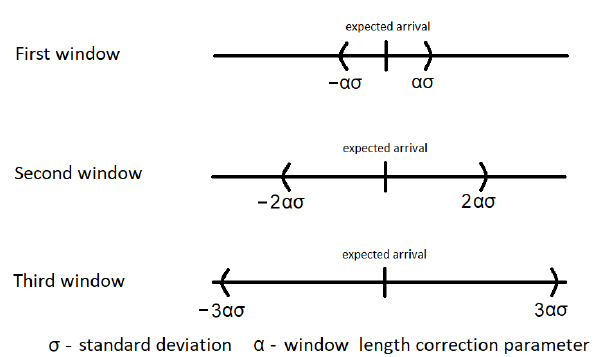
Figure 2. Linear increasing of time